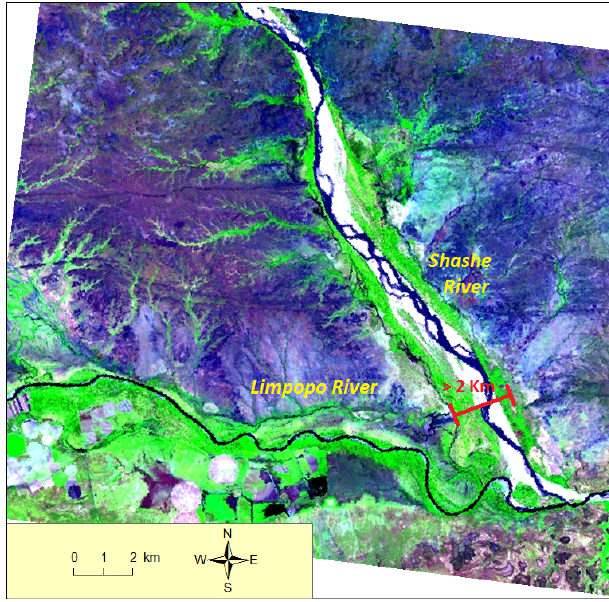
Figure 10. False colour-composite Landsat 7 satellite image of 2000 (30m resolution) showing the confluence between the Shashe and Limpopo rivers.